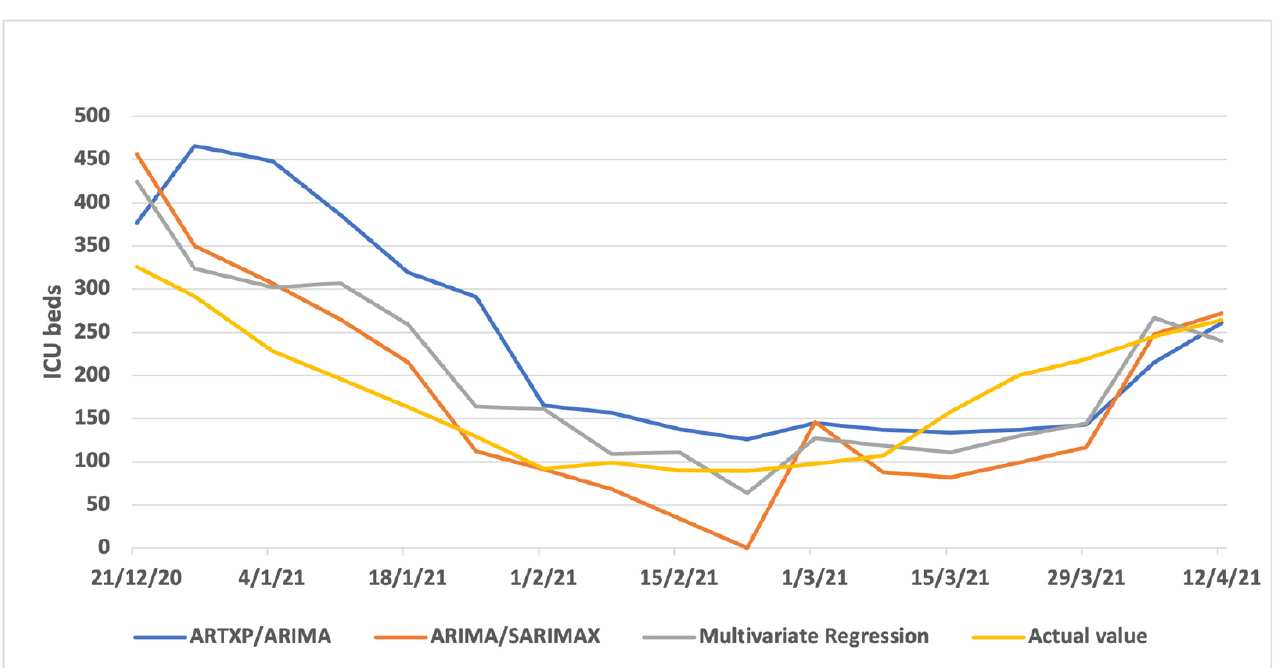
Figure A5. Two weeks Predicted vs. Actual ICUs—Northern Greece.